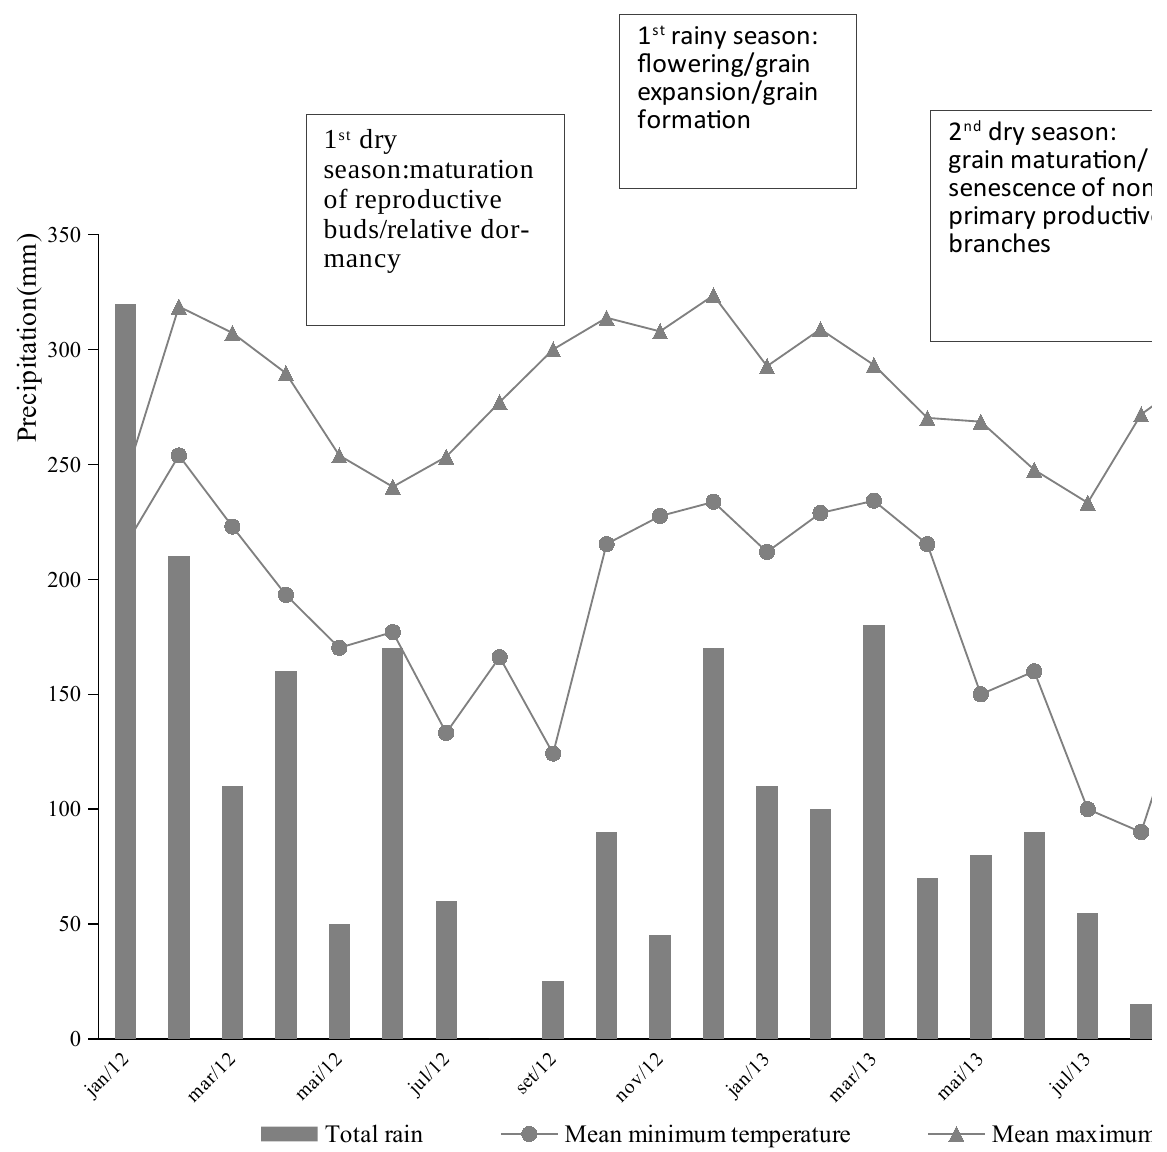
Figure 1. Monthly minimum and maximum mean air temperatures, rainfall distribution and phenological stage of coffee plants in FACE